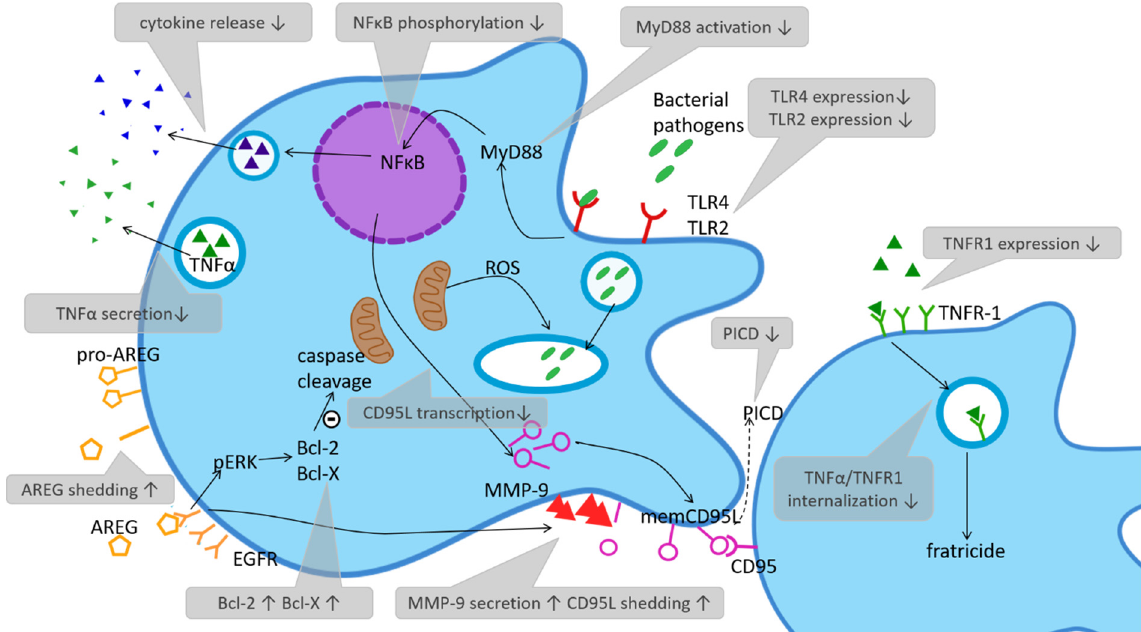
Figure 1. Pathogen recognition, phagocytosis, killing and phagocytosis-induced cell death in cord blood derived monocytes. Alterations in neonates compared to adults are named in grey text boxes, small arrows indicate an increase or decrease. Abbreviations: NF κ B (nuclear factor ‘kappa-light-chain-enhancer’ of activated B-cells), MyD88 (Myeloid differentiation primary response 88), TLR (Toll-like receptor), TNF (tumor necrosis factor), TNFR (tumor necrosis factor receptor), PICD (phagocytosis induced cell death), CD95L (CD95 ligand or Fas ligand), memCD95L (membrane- bound CD95 or Fas ligand), MMP-9 (matrix metalloproteinase 9), Bcl (B-cell lymphoma), EGFR (ep- idermal growth factor receptor), AREG (amphiregulin), pERK (phosphorylated extracellular signal- regulated kinase).